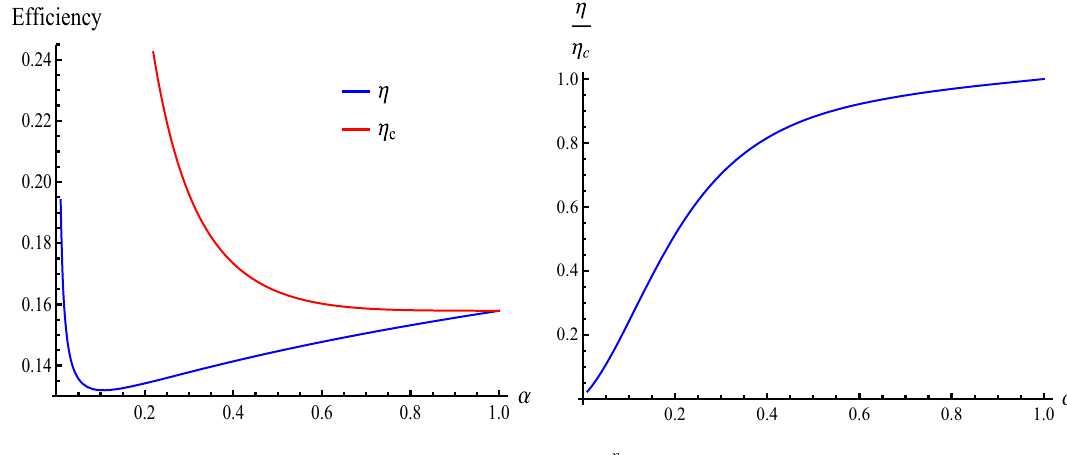
under the condition of a = 0 c